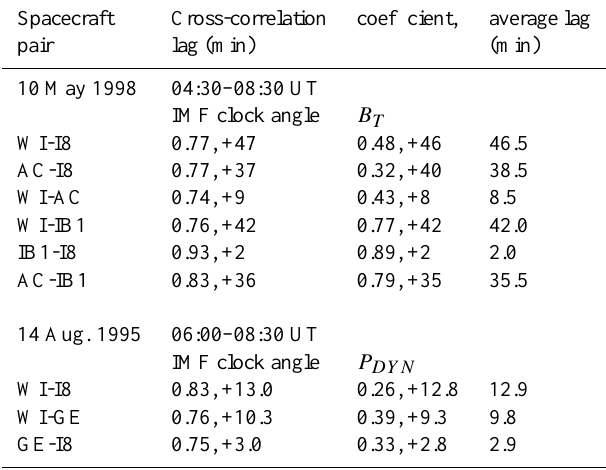
Table 1. The inter-spacecraft cross-correlation and lag for the time series of the IMF clock angle, B T or P DYN Spacecraft Cross-correlation coefficient, average